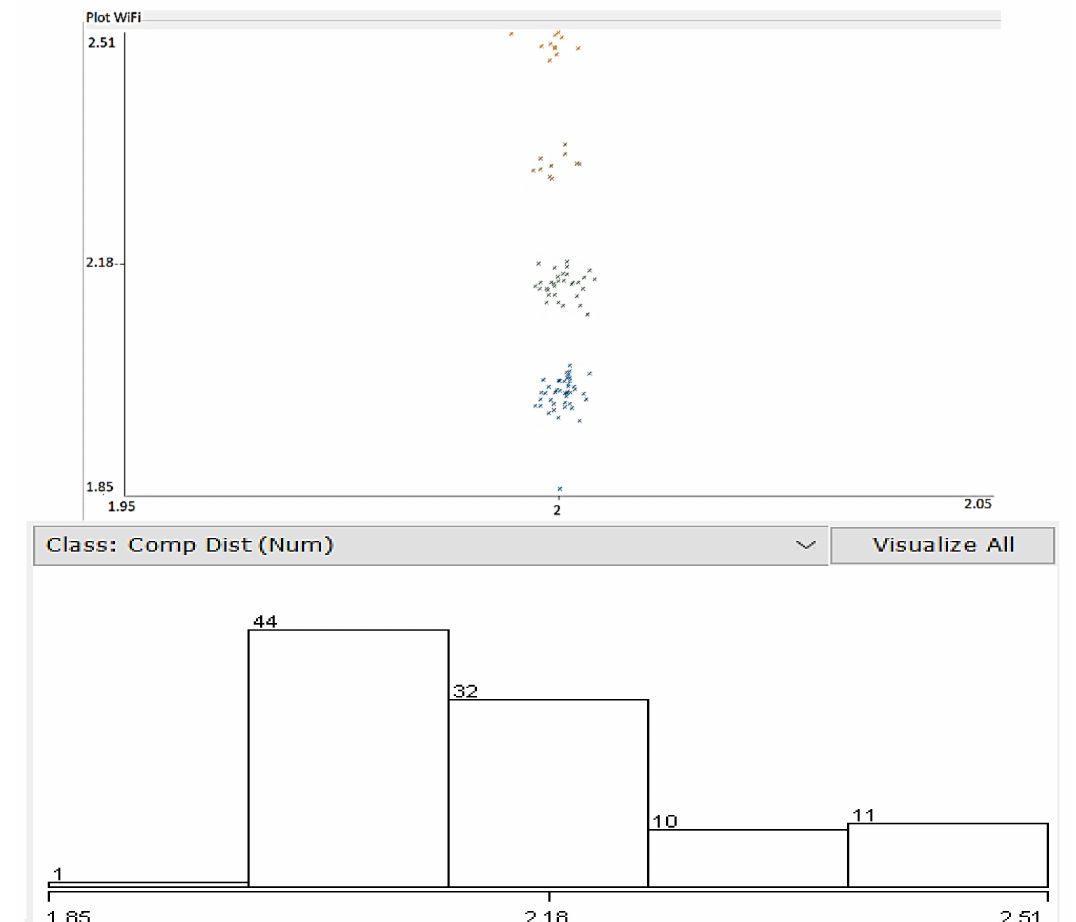
Figure 12. Distance to Wi-Fi AP computed from measured signal strength vs. real distance distri- bution, plotted in Weka environment. Colors represent belonging of distances to different clusters. Lower figure: Horizontal axis: computed distance, vertical axis: number of